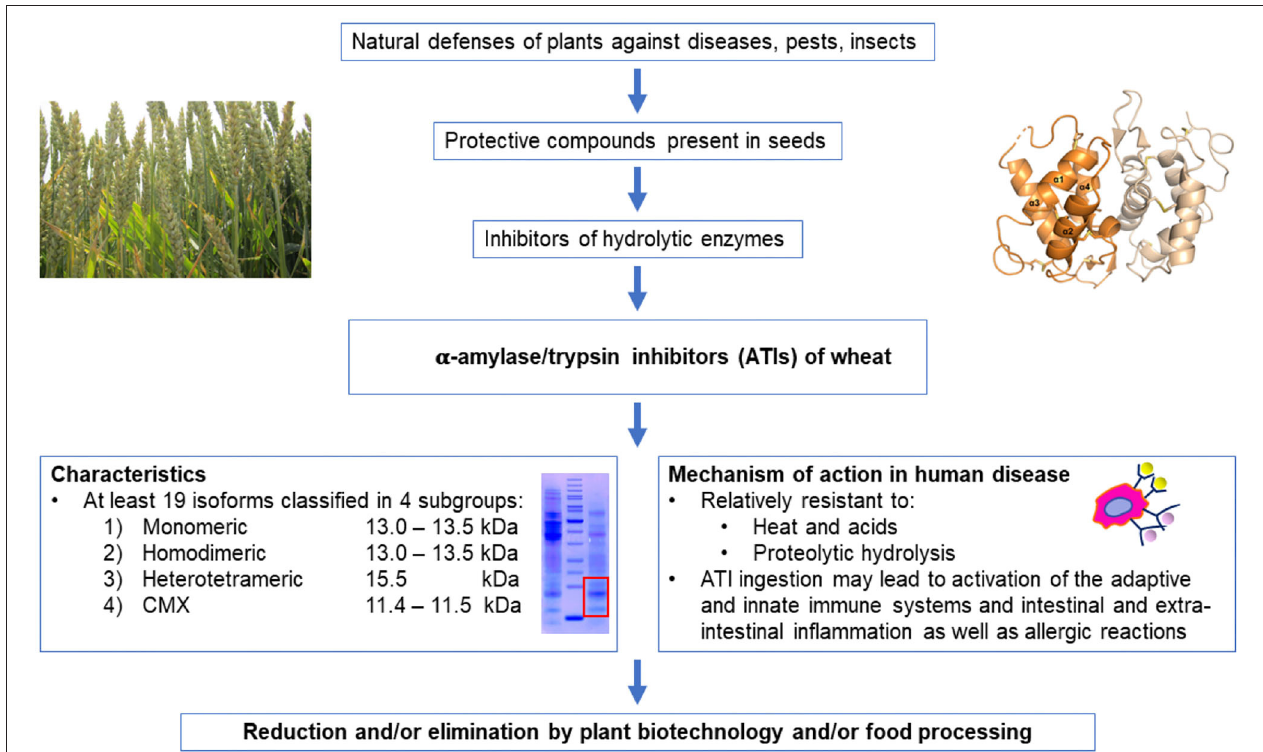
FIGURE 1 | Condensed overview of the presence and key-characteristics of ATIs in wheat and their potential effects in the human